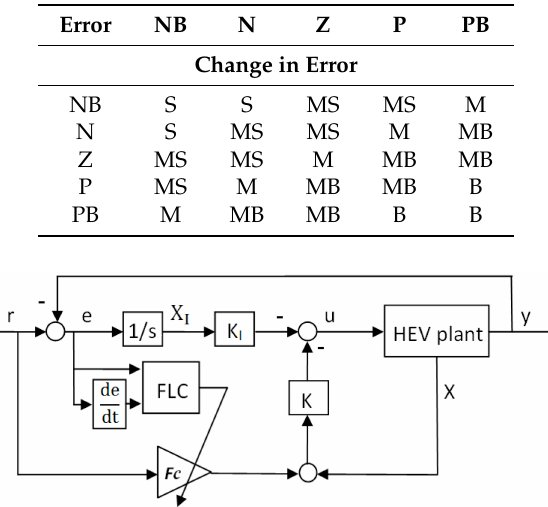
Figure 6. Block diagram for the HEV longitudinal speed control with the 2-DoF fuzzy controller. FLC, fuzzy logic